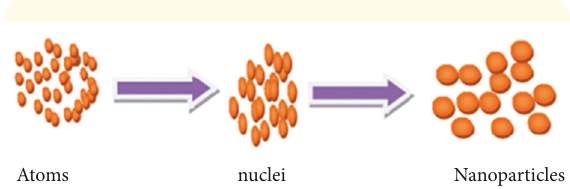
Figure 2: Structures of nanoparticles are fabricated by chemical procedures